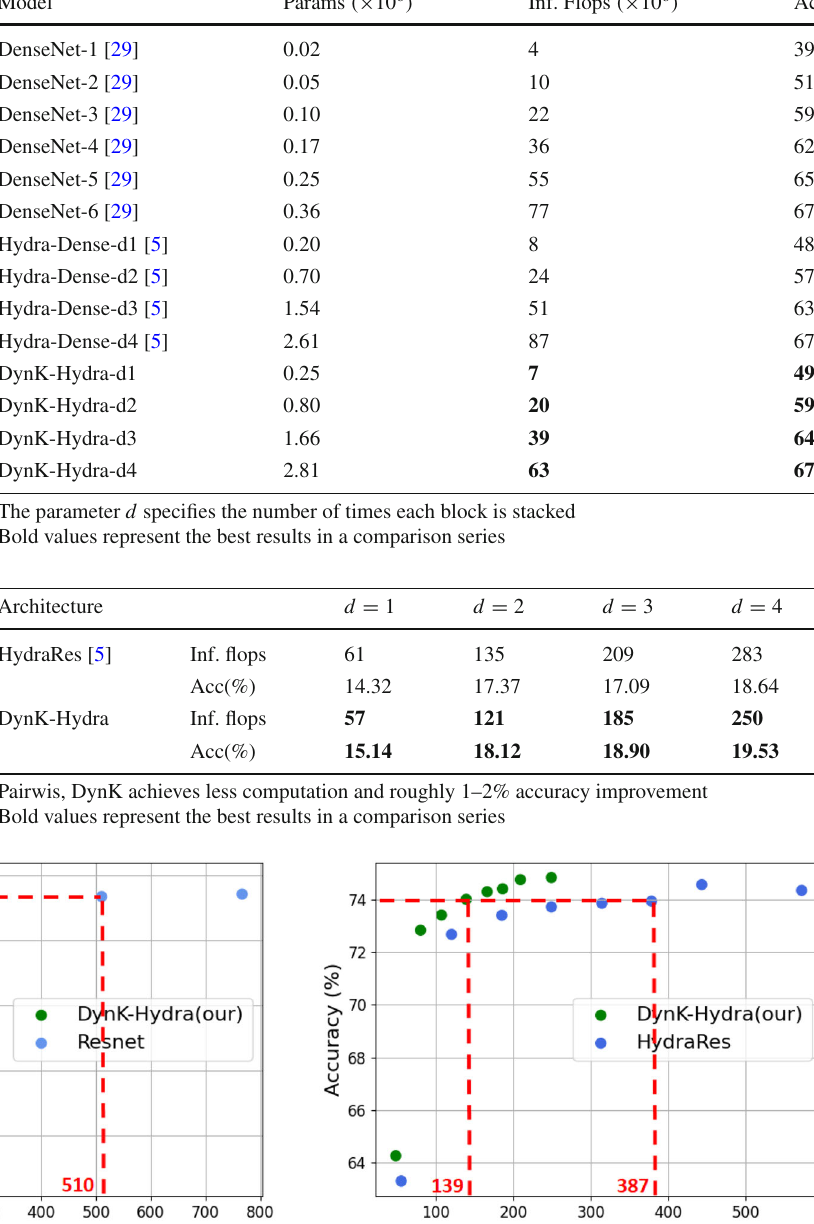
Table 2 Comparison of our DynK-Hydra with Hydra-Dense [5] and DenseNet [29] on CIFAR-100